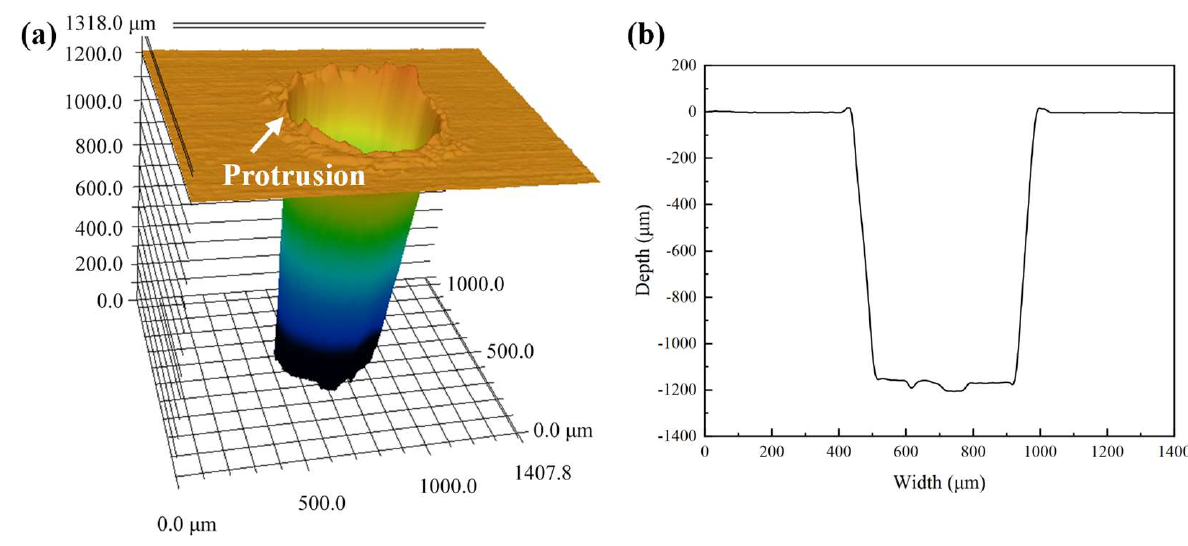
Figure 13. Hole machined by laser in air. ( a ) 3D profile, ( b ) Cross-sectional profile.